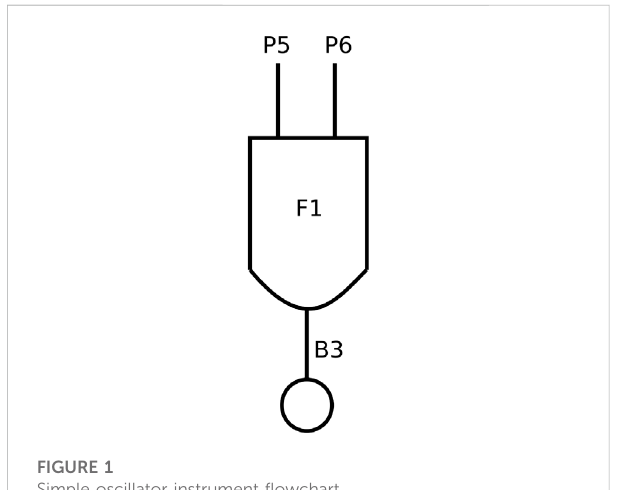
FIGURE 1 Simple oscillator instrument fl